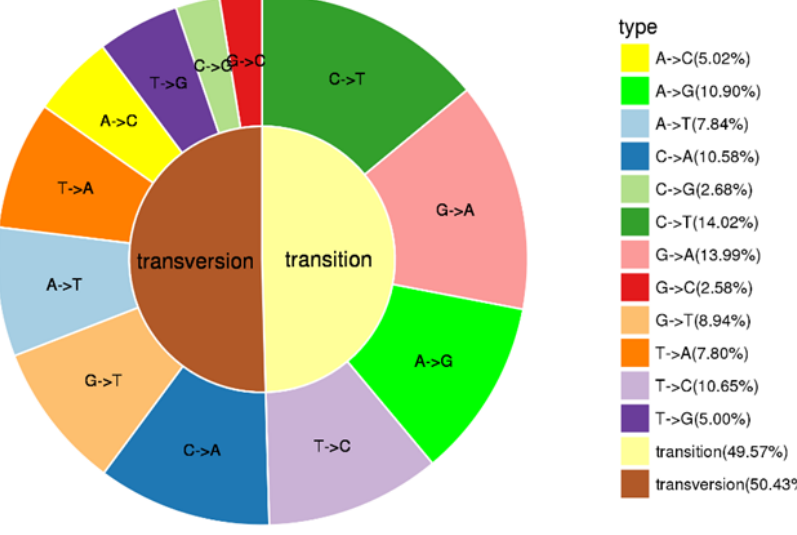
Figure 2. Types of Figure 2. Types of SNPs.